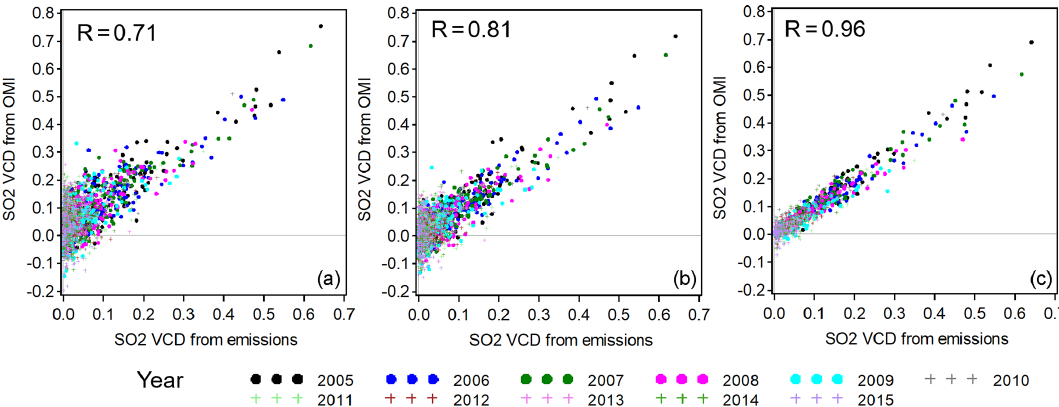
Figure 3. The scatter plots between the reconstructed from emission-based VCDs and the three OMI-based data sets shown in Fig. 1: (a) mean OMI SO2 VCDs, (b) mean OMI SO 2 VCDs with a large-scale bias removed, and (c) results of the fitting of OMI data by the set of functions that represent VCDs near emission sources using estimated emissions (the first term of Eq. A2). Each symbol on the plot represents the annual mean SO 2 VCD value averaged over one 1 ◦ by 1 ◦ grid cell and all cells within the domain area shown in Fig. 1 are included in the plot. Different colours represent different years. The correlation coefficients between the two data sets on each plot are also